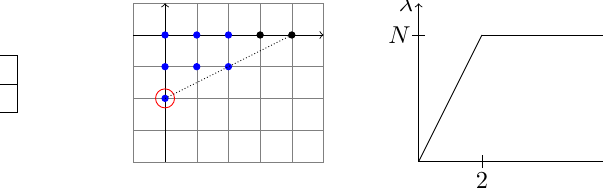
(b) The puncture with G F = SU( N/ 2) , corresponding to the box diagram Y ‘ with ‘ = N/ 2 . Here, p ‘ =1 ,...,N/ 2 = ‘ − 1 and p ‘ = N/ 2+1 ,...,N = ‘ − 2 , such that in the diagram shown p ‘ = { 0 , 1 , 1 , 2 } .